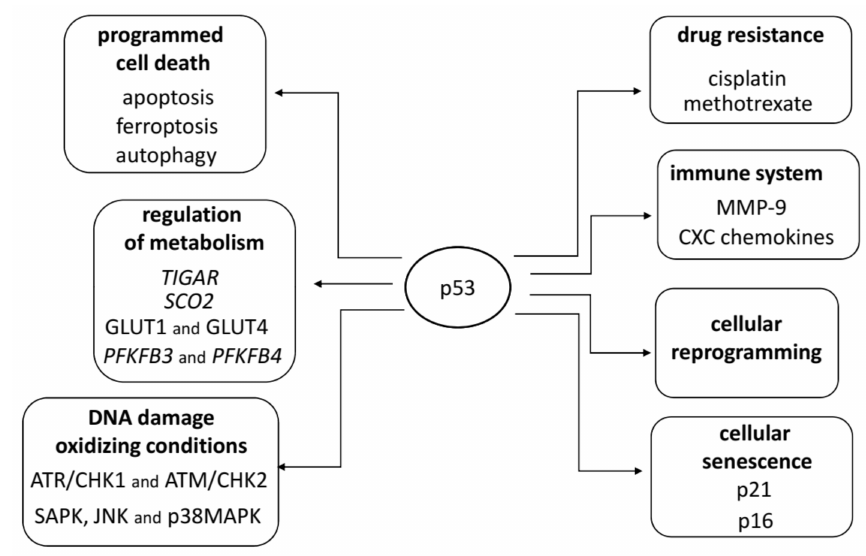
Figure 1. The main functions of p53 in the cell life and